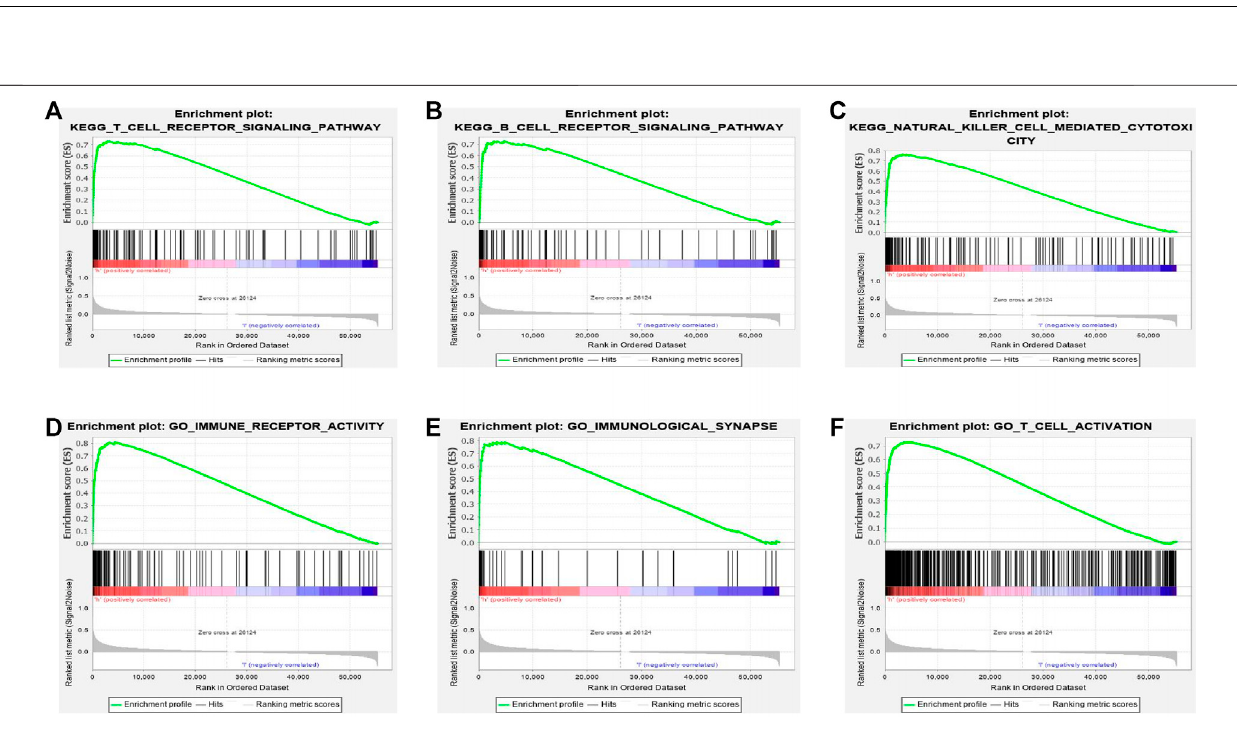
Frontiers in Genetics |